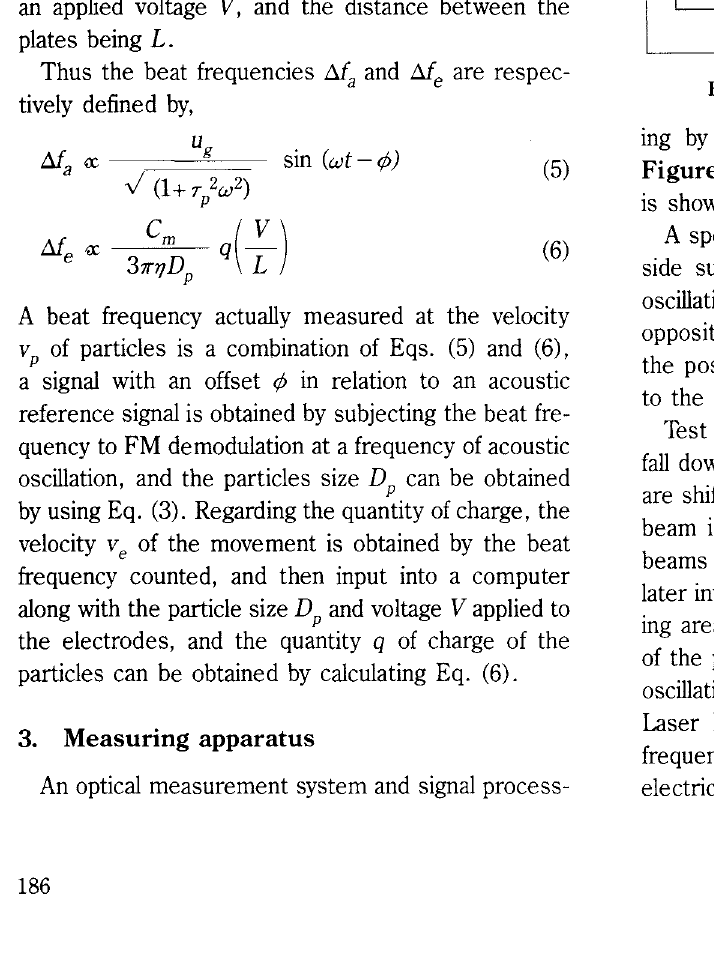
Fig. 2 Optical system and signal processing by the laser Doppler method